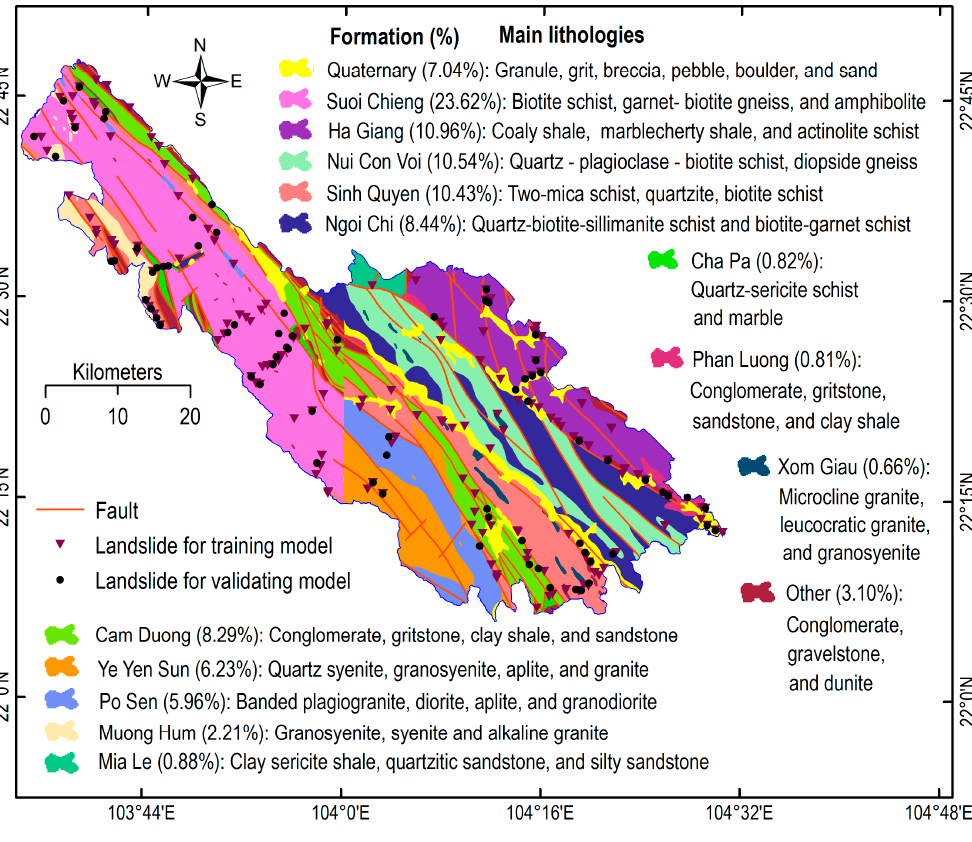
Figure 2. Geological map of the study area.